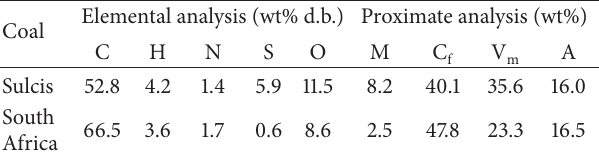
Table 1: Elemental and proximate analysis data of investigated coals ∗